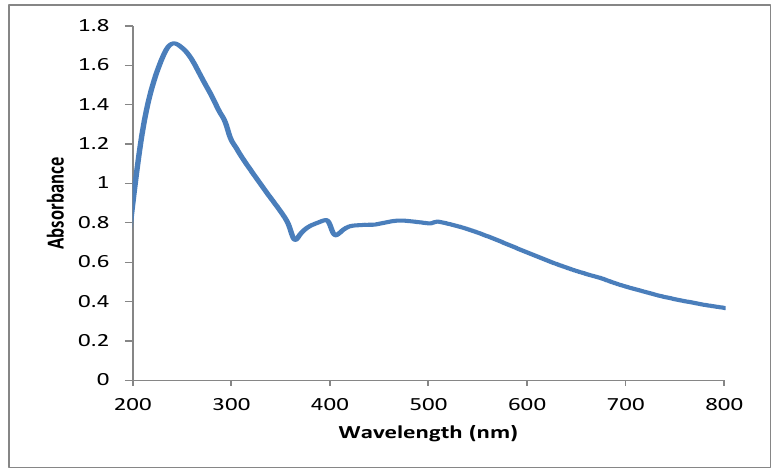
Figure 2. UV-vis spectrum of the biogenic AgNPs synthesized utilizing pomegranate peel extract.